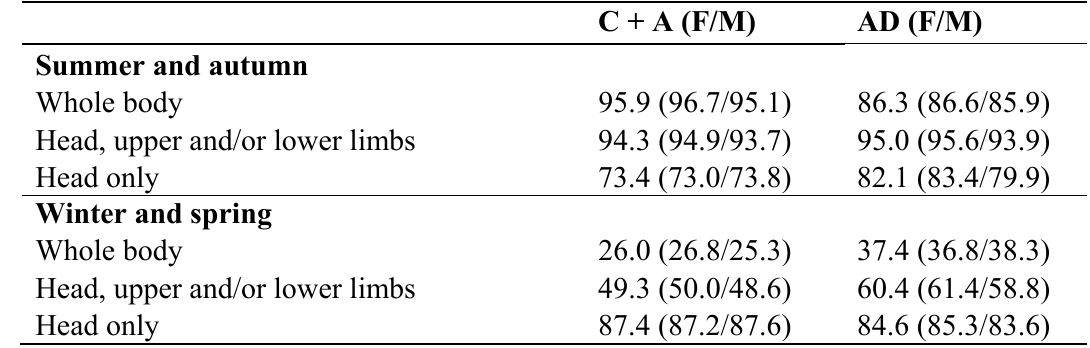
Table 2. Prevalence of sunscreen use on different body areas by season (%